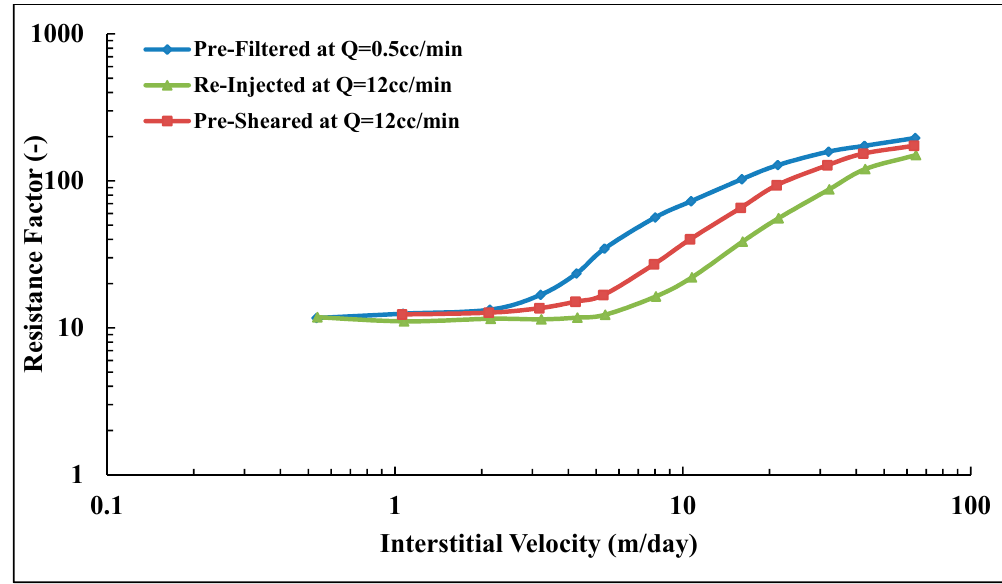
Figure 8. Resistance factor ( RF ) vs. interstitial velocity for Solution A.